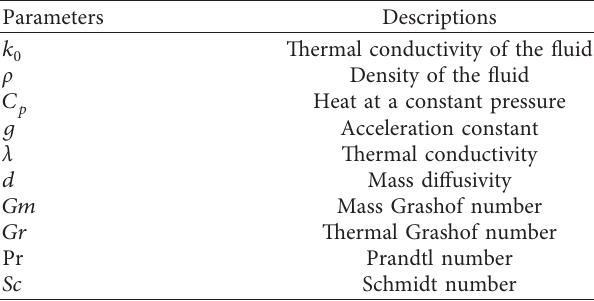
Table 2: Nomenclature